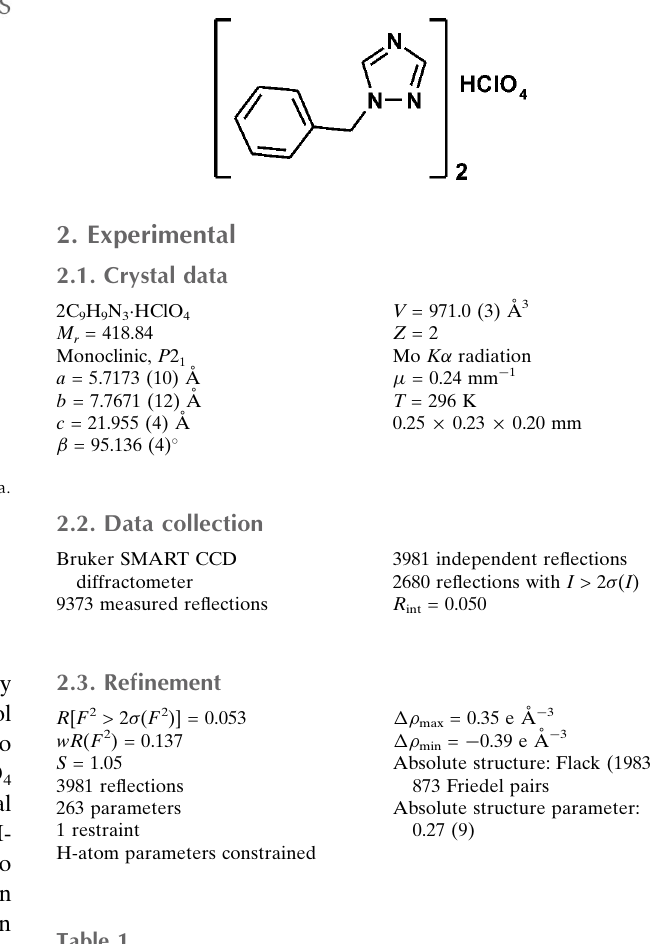
Hydrogen-bond geometry (A˚ , (cid:3)